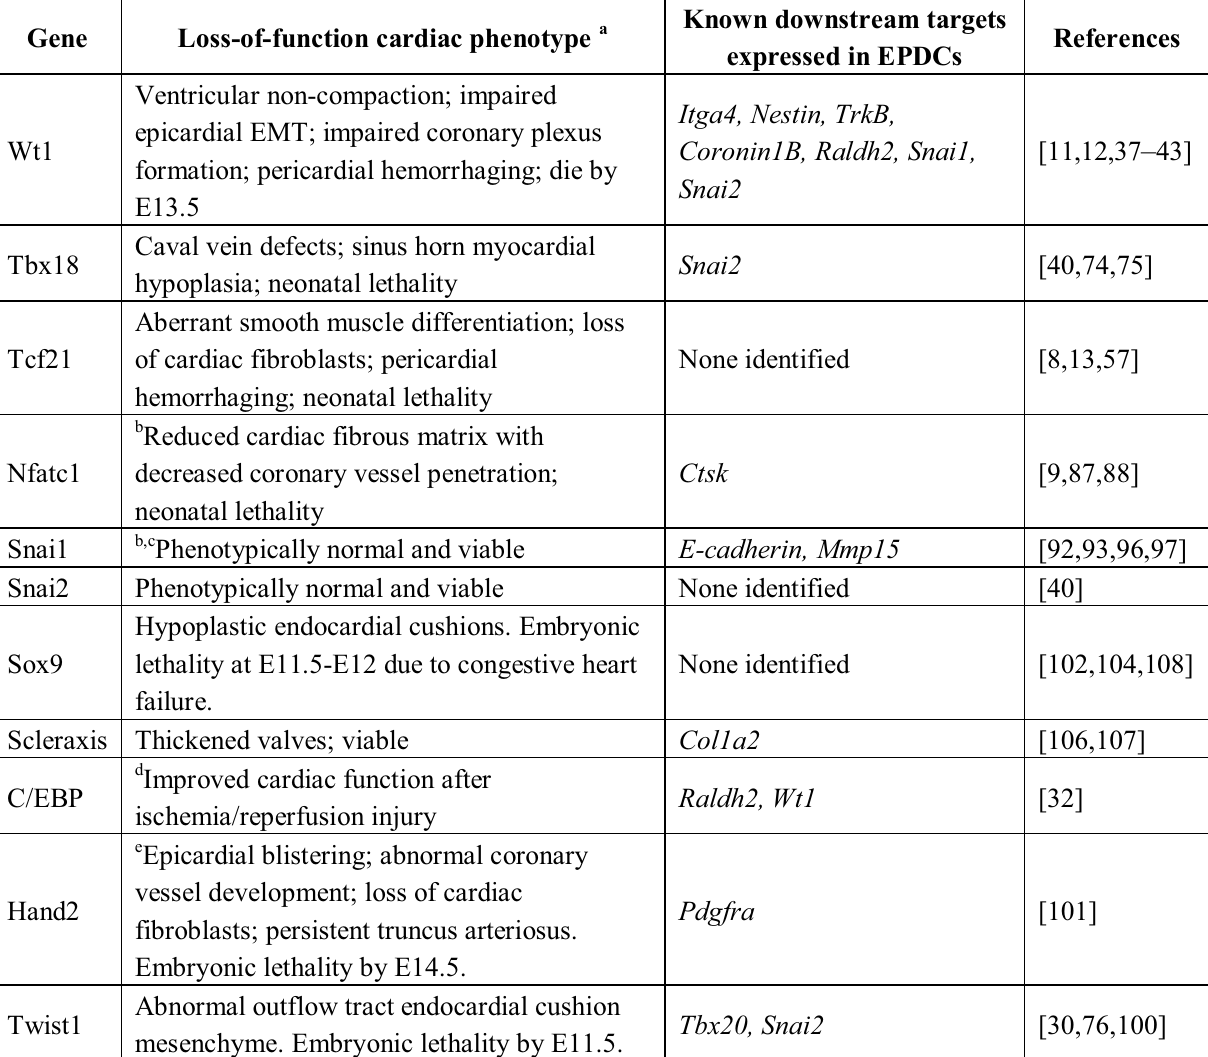
Table 1. Transcription factor expression and function in epicardial development (see text for details and